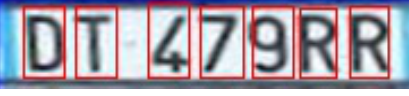
Figure 8. Output